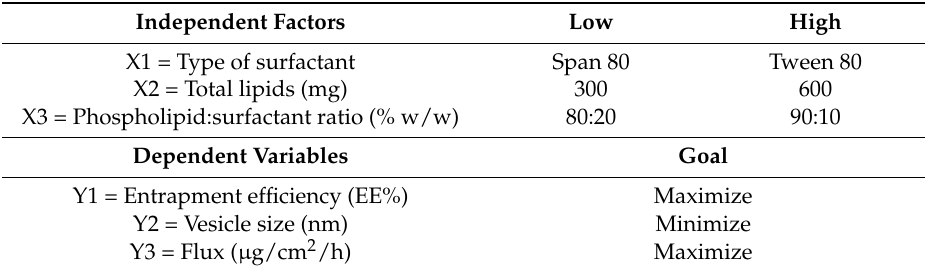
Table 1. Formulation factors for the multilevel factorial